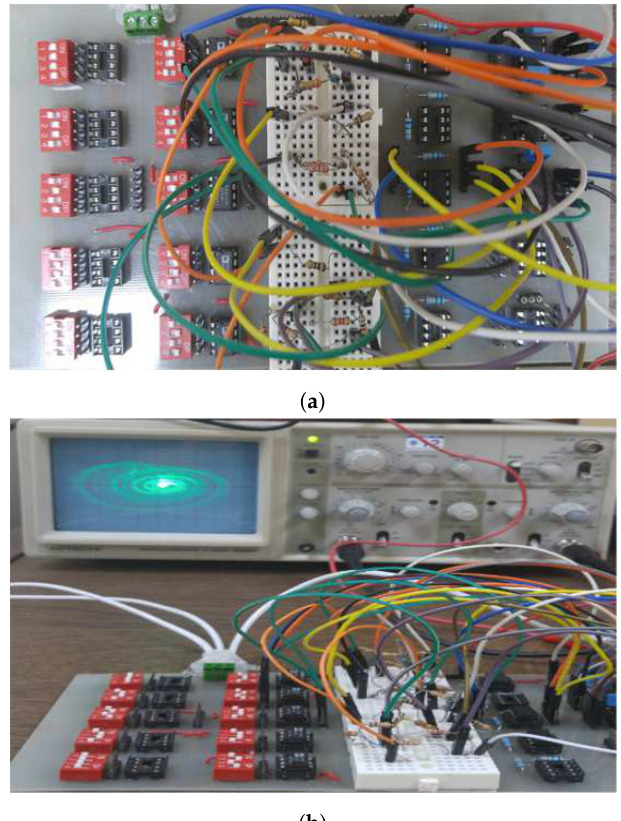
Figure 4. Real electronic circuit implemented using a board. ( a ) the electronic board, ( b ) the measurement of the circuit by using the